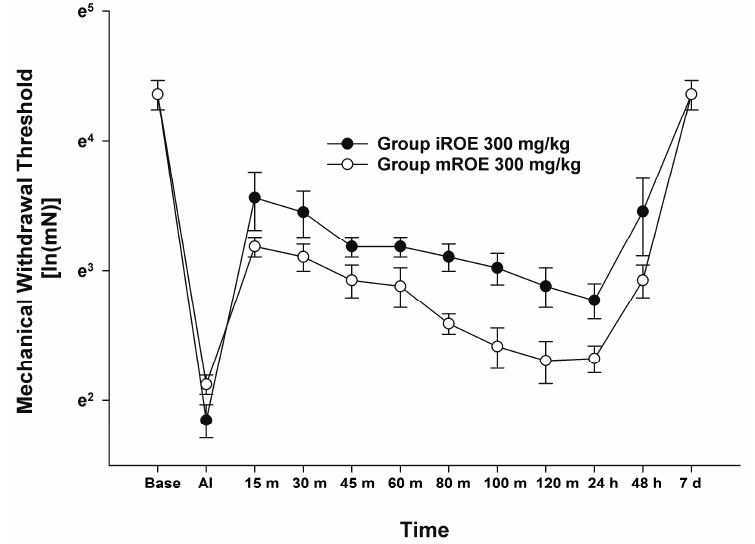
Figure 3. Analgesic effect of immature R. occidentalis versus mature R. occidentalis. iROE, immature Rubus occidentalis extract; mROE, mature Rubus occidentalis extract; AI, after incision.